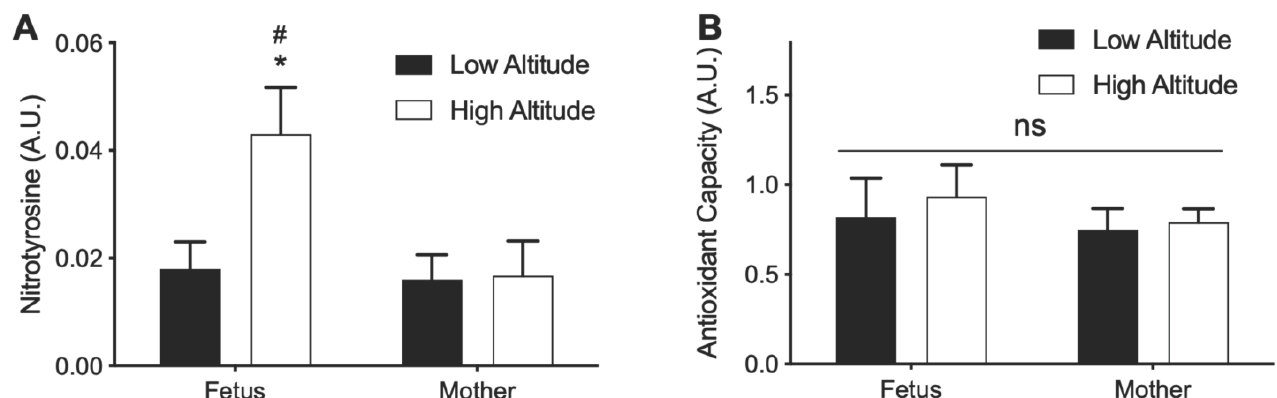
Figure 6. Nitrotyrosine and antioxidant capacity in aorta from high- and low-altitude pregnant sheep. ( A ) Nitrotyrosine. ( B ) Antioxidant capacity. Measurements were normalized to protein concentrations in the homogenates. Two-way ANOVA with Sidak’s post-hoc tests. * = p < 0.05 high vs. low altitude. # = p < 0.05 fetus vs. mother.